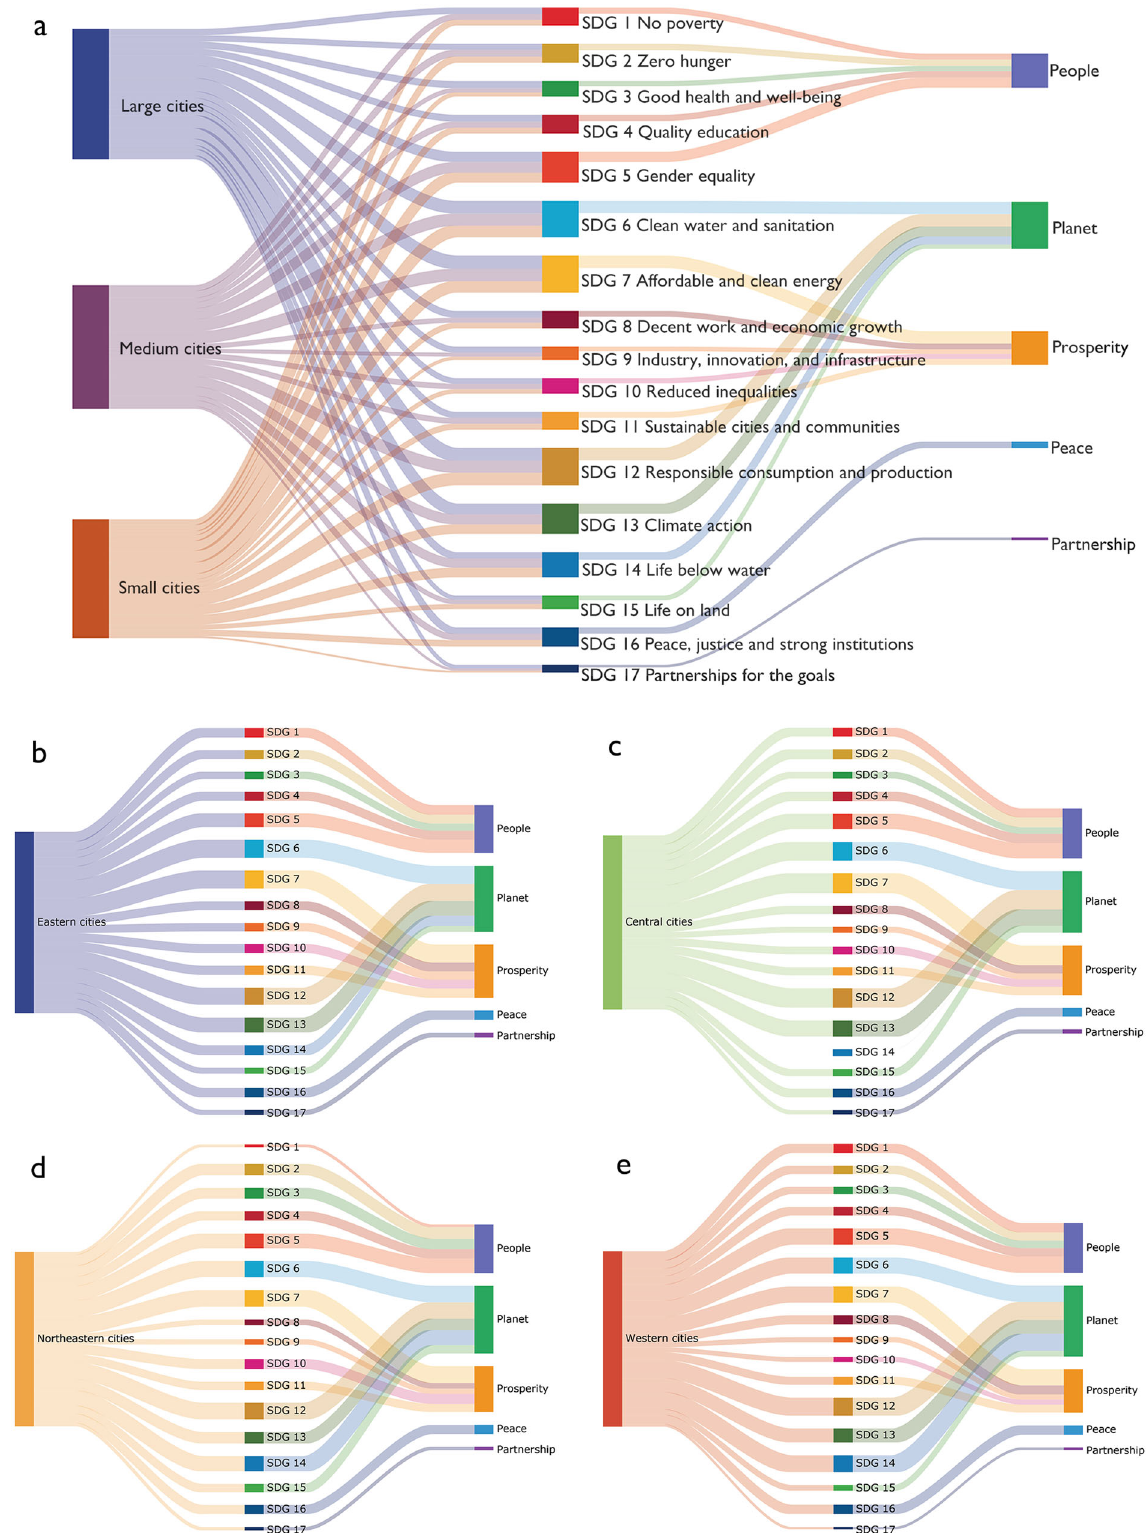
Fig. 1 Comparison of average individual SDG scores for different city groups. a City size. b – e Spatial location. Five critical dimensions of the 2030 Agenda: people, prosperity, planet, peace, and partnership. A total of 254 cities were involved, and their average individual 17 SDG scores were calculated according to their size (large, medium, or small) and spatial location (eastern, central, northeastern, or western). For each subgraph, thicker lines represent higher